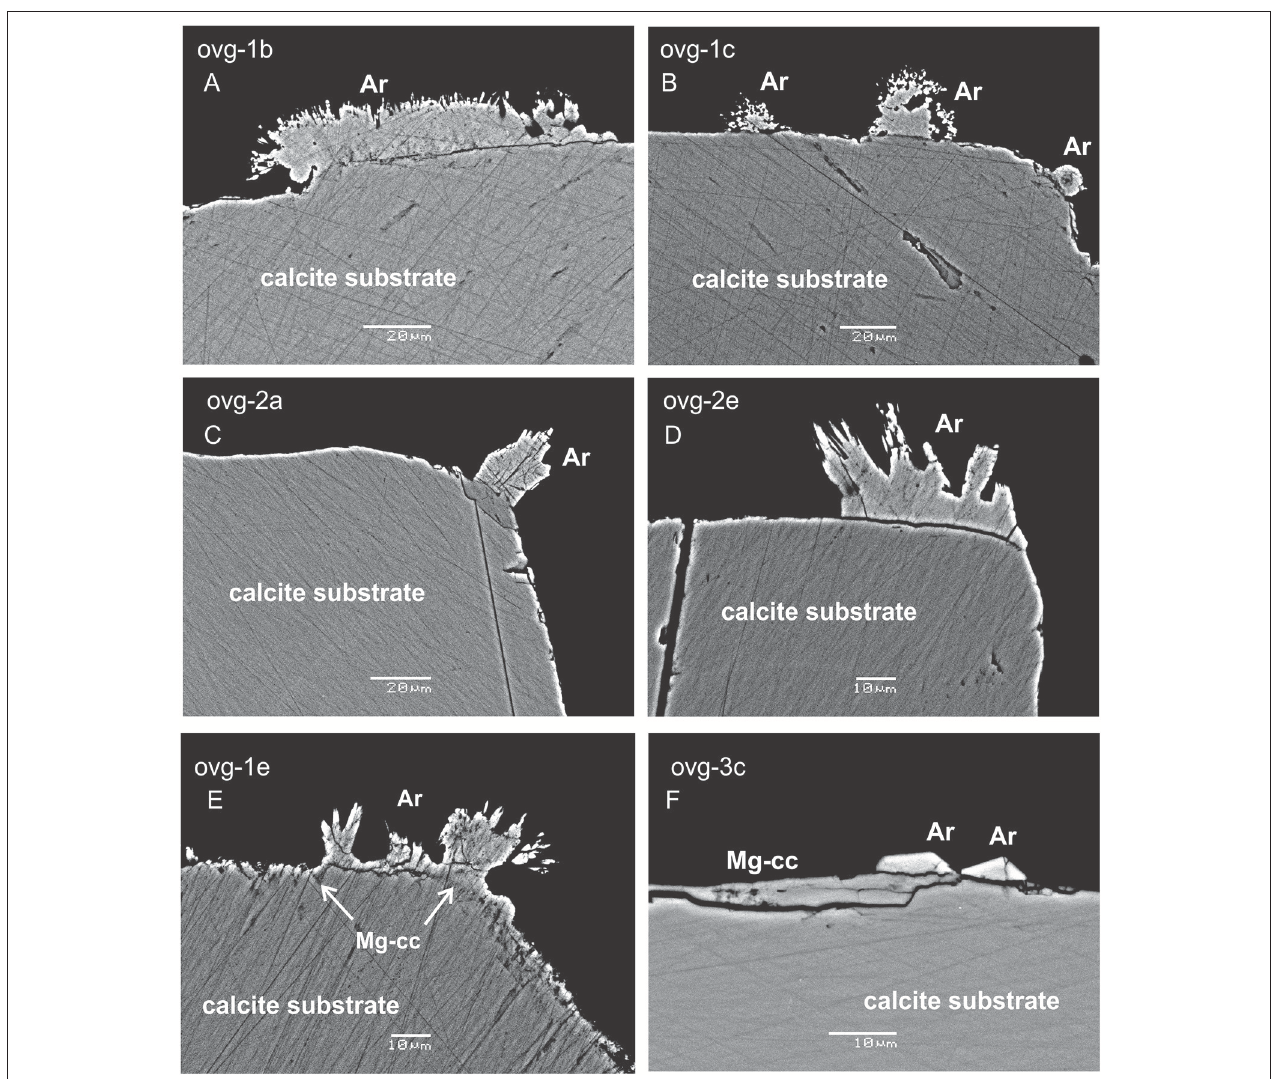
FIGURE 1 | SEM BSE images of calcite substrate and new formed crystals. Acicular crystals of aragonite (Ar) are radiating away from the substrate in the experiments ovg-1 and ovg-2 (A–E) ; aragonite monocrystals and thin layer of new-formed calcite (Mg-cc) are growing on the substrate in ovg-3 experiment (F) . Scale bars are 20 µ m in (A–C) and 10 µ m in (D–F)